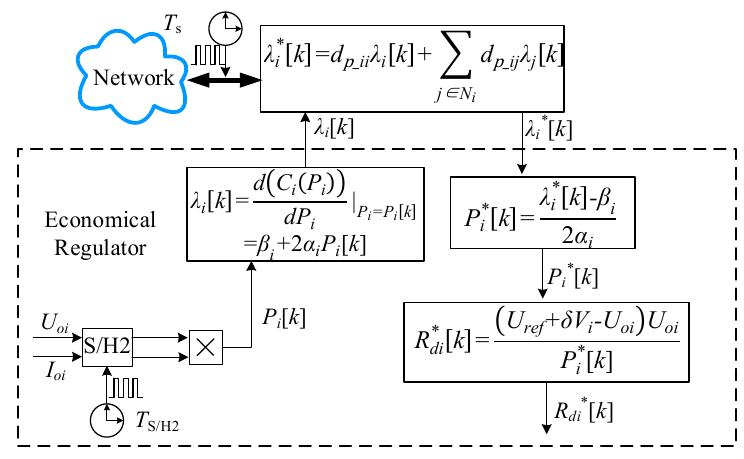
Figure 3. Economical regulator in tertiary control level.